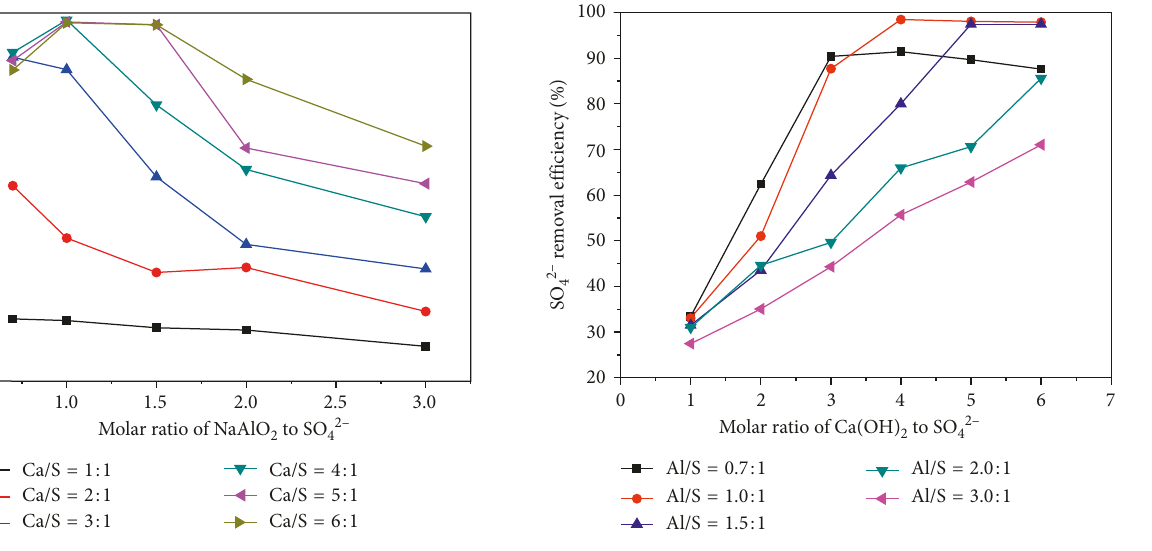
2 dosage. V solution (cid:27) 1L, T (cid:27) 25 7.0. (cid:27)